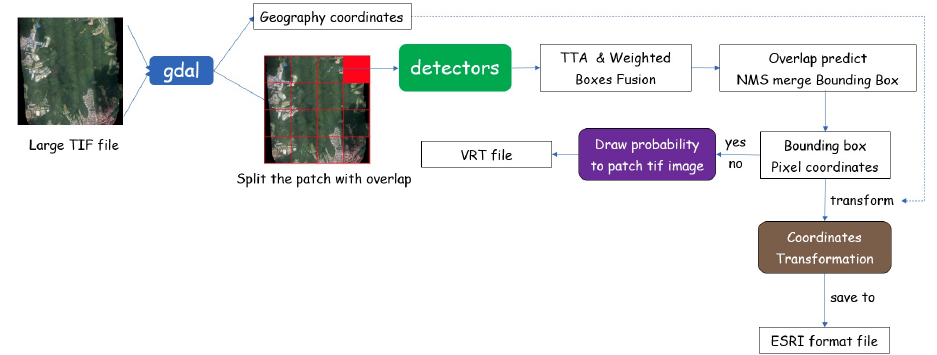
Figure 6. Pipeline of the automatic PWD diagnosis